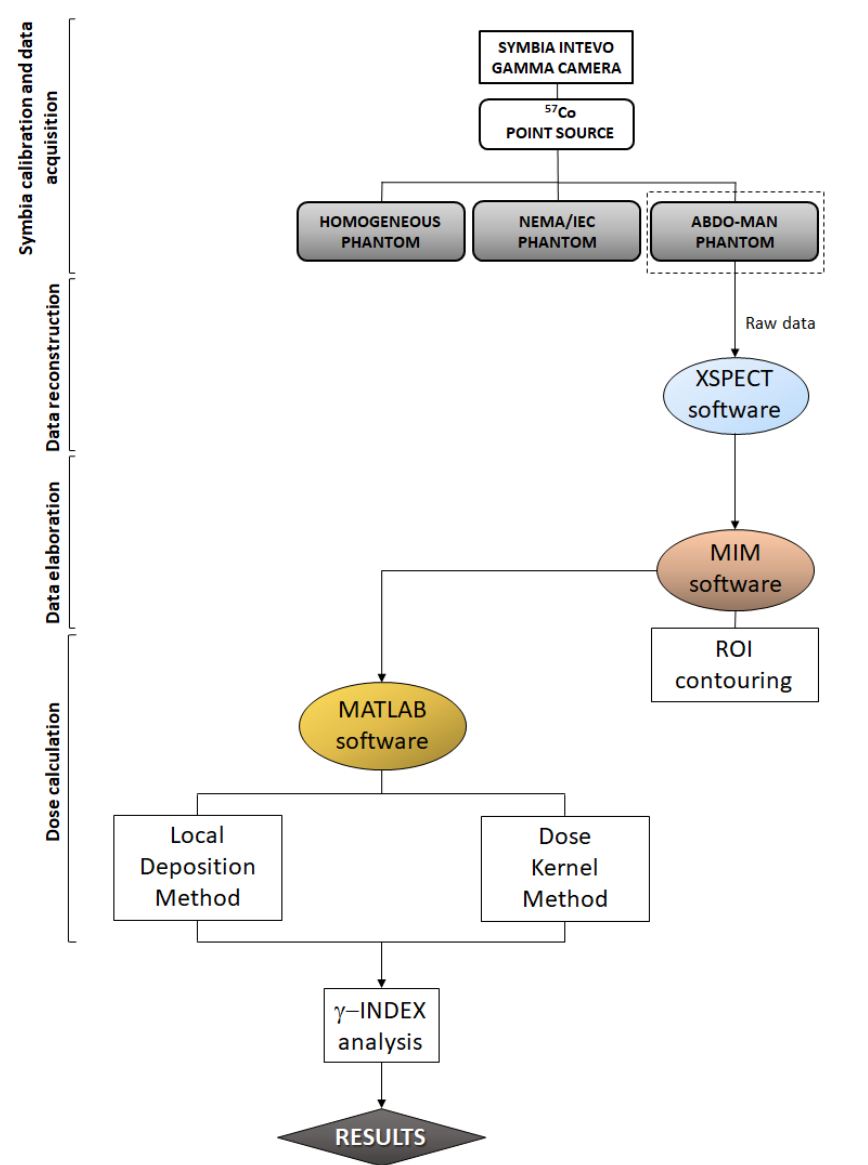
Figure 2. Flowchart of the experimental method adopted in this